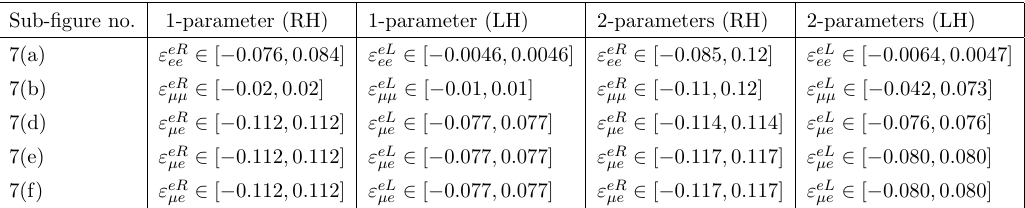
Table 5 . Future prospects: parameter bounds are listed for the detector-only study. (cid:28) can be substituted for (cid:22) in all entries to obtain the corresponding (cid:28) limits. Both 1-parameter and 2- parameter bounds are given here at the 90% C.L..